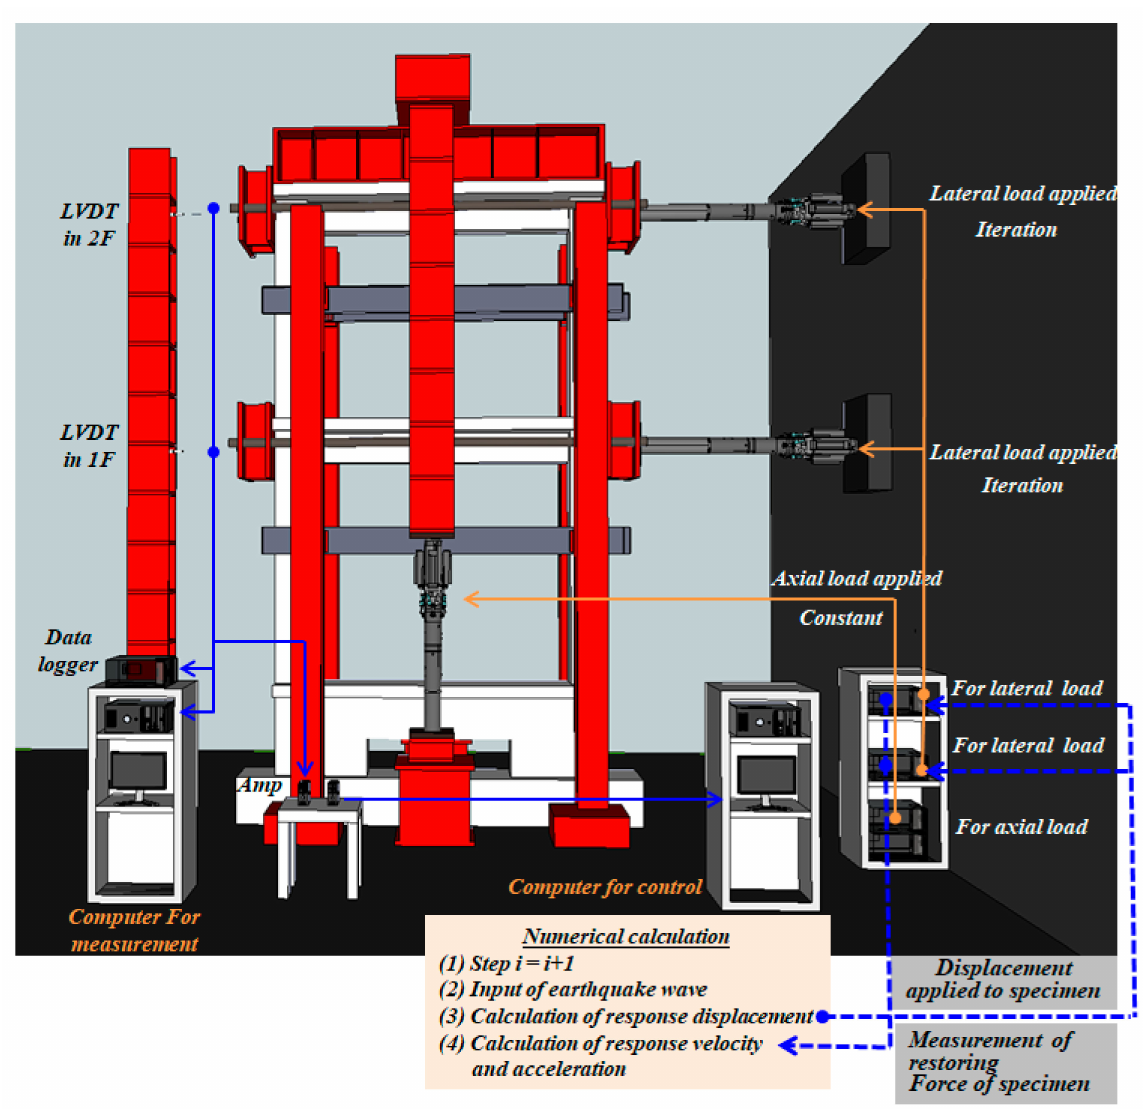
Figure 6. Illustration of the pseudo-dynamic testing system developed in the present